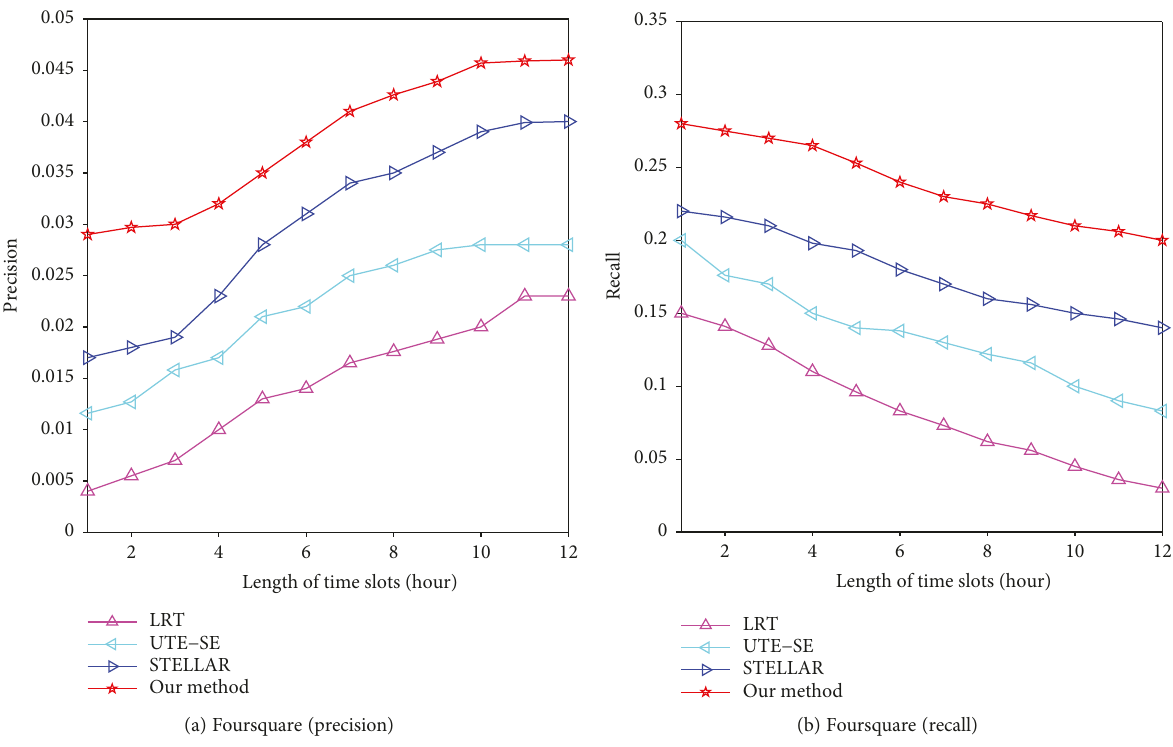
Figure 11: Performance of the varying length of time slot on the Foursquare